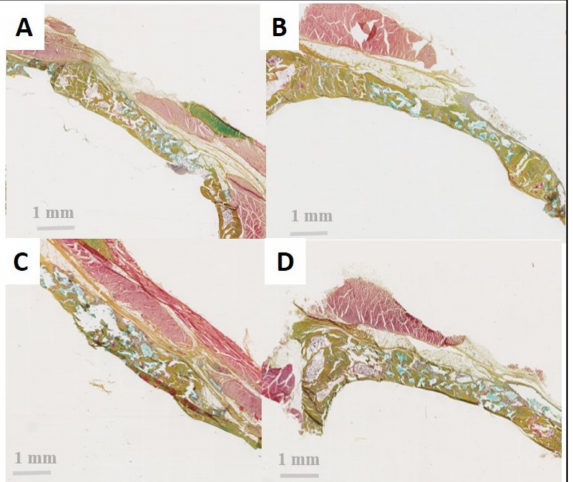
Figure 11. Histological views after 8 weeks of healing (Movat staining). ( A ) Positive control with collagen membrane, ( B ) Si-HPMC, ( C ) DexMA, and ( D ) IPN. In all groups and in the positive control, the delineation between the BCP granules and the soft tissue is readily apparent. There is no invagination of the soft tissue, thus confirming the barrier effect of the membranes. The new bone formation appears more homogeneous in the IPN and the positive control compared with the Si-HPMC and DexMA